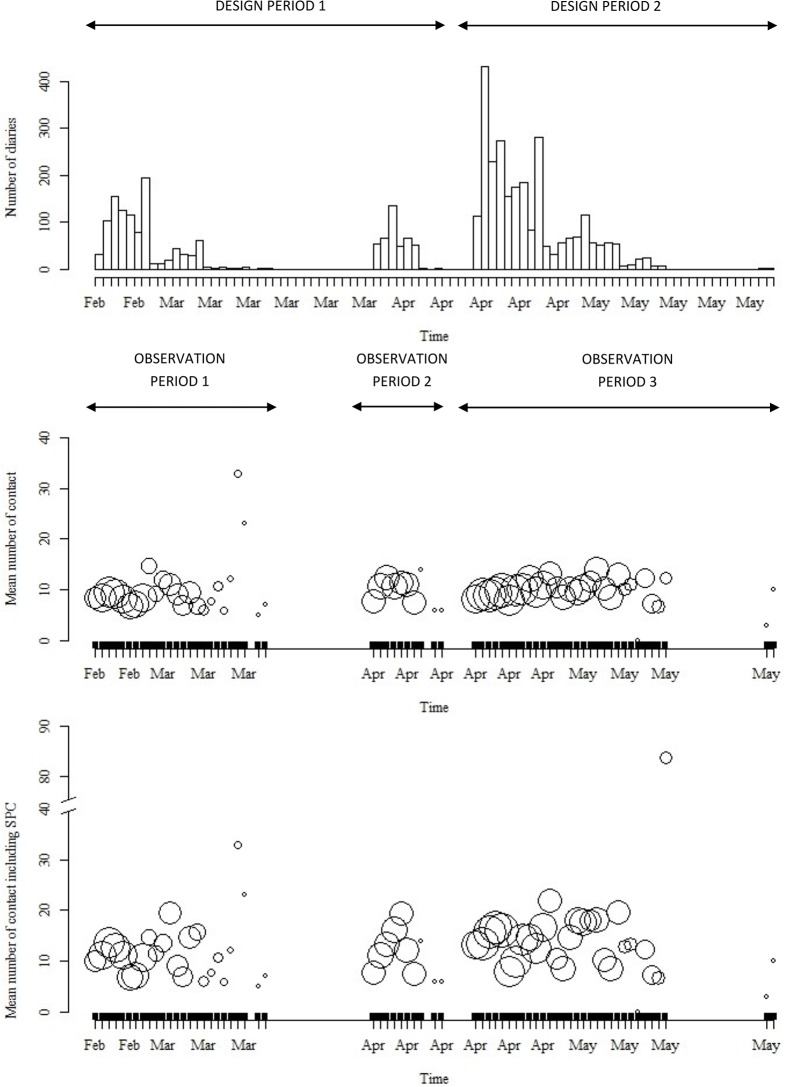
Timeline of the study, showing the distribution of participants and contacts over time.The periods of inclusion were February, 20th–March,17th; April,1st–April, 7th; April,16th–May, 14th. The dot size is proportional to the log of participant’s number. (Design Period 1: 34 days; Design Period 2: 29 days)